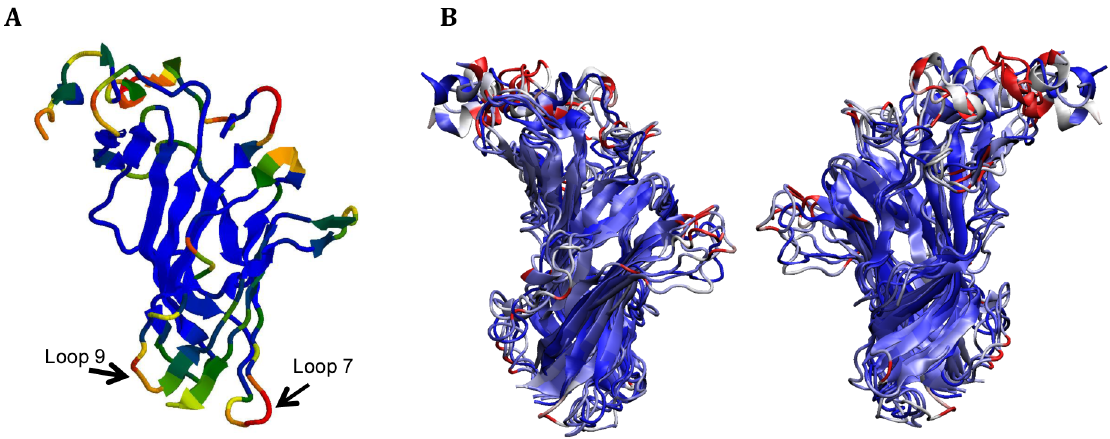
Figure 2. Model of GlyBP. A) Structure of a single GlyBP subunit is shown in a ribbon representation. Colors represent mobility of individual residues in MD simulations. Mobility is measured by root mean squared fluctuations (RMSF) with respect to an average structure obtained in a steady- state dynamics. The coloring scheme is as follows: RMSF , 0.8 A˚ - blue, RMSF range 0.8–1.3 A˚ - green, 1.3–1.5 A˚ –yellow, 1.5–1.8 A˚ – orange, RMSF . 1.8 A ˚ - red. B) Conformational diversity of subunits within the GlyBP pentamer is shown by a structural superposition of average monomer structures (last 2 ns of the trajectory) color coded by root mean squared deviation between subunits. Front (outer side) and back (inner side) are shown in the left and right panels, respectively.